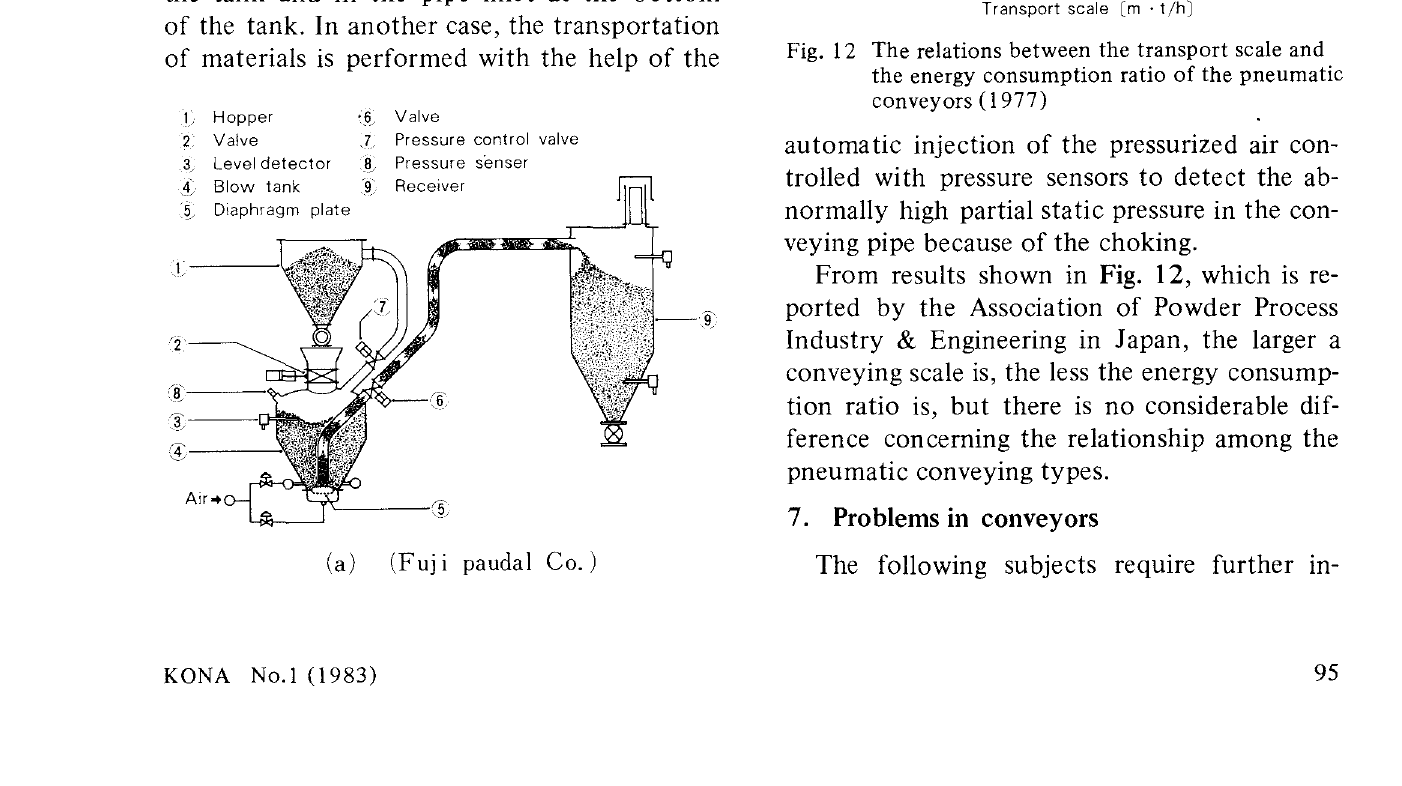
Fig. 12 The relations between the transport scale and the energy consumption ratio of the pneumatic conveyors (